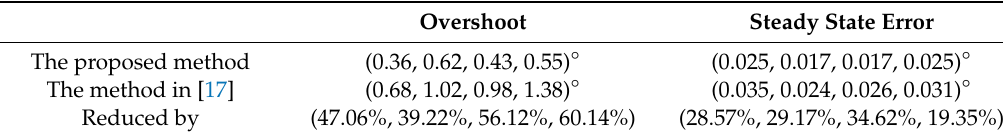
Figure 3. Step response curve of each joint of underwater manipulator. ( a ) Step response curve of 1st and ( b ) step response curve of 2st. Table 2. Statistical Results of Figure 3a.